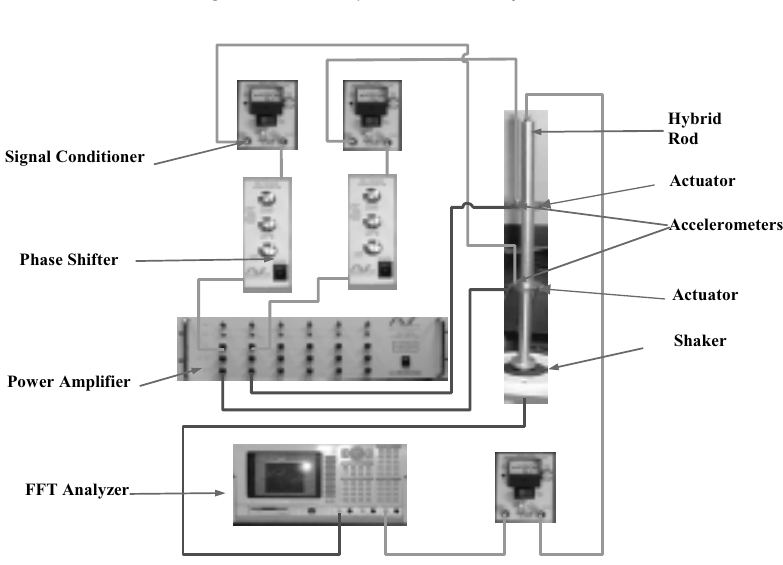
Fig. 8. Test setup for evaluating the vibration transmission characteristics of the